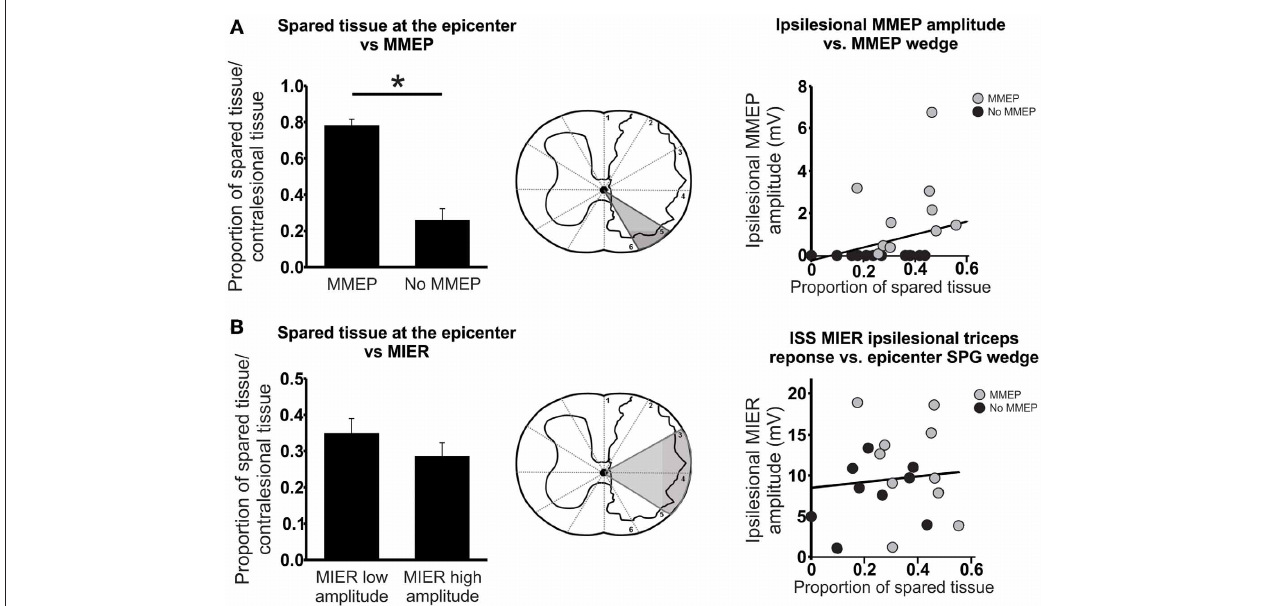
FIGURE 6 | Anatomical evaluation of tissue sparing related to the MMEP or the MIER responses. (A) Magnetic motor evoked potentials (MMEP) are transmitted in the ventrolateral white matter of the spinal cord. Animals that failed to exhibit ipsilesional MMEPs had significantly less spared tissue within this ventrolateral portion of the spinal cord at the lesion epicenter. Correlational analysis revealed a significant relationship between the amplitude of the MMEP response and the proportion of tissue sparing in the